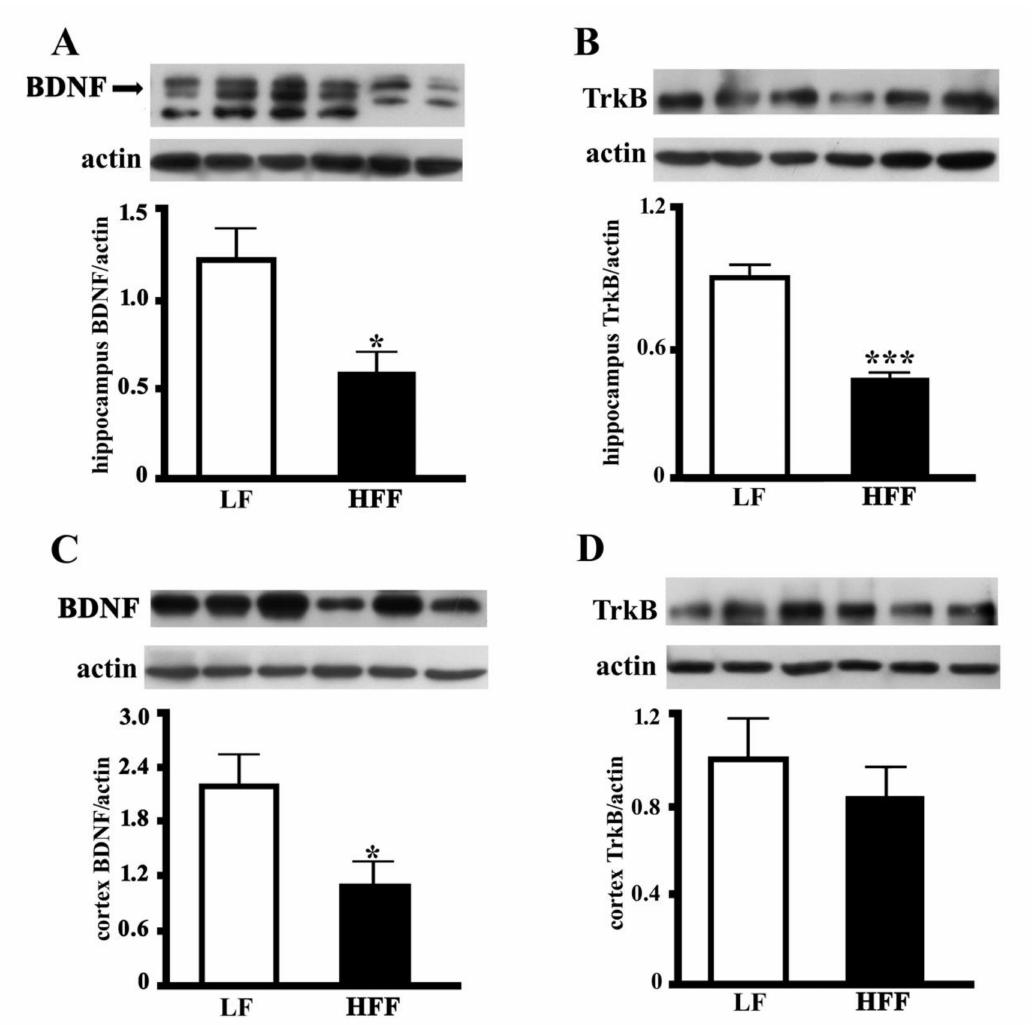
Figure 9. Protein content (with representative western blot) of brain derived neurotrophic factor (BDNF) and tropomyosin receptor kinase b (TrkB) levels in hippocampus ( A , B ), and frontal cortex ( C , D ) from middle-aged rats fed low fat (LF) or high fat-high fructose (HFF) diets for four weeks. Values are the means ± SEM of eight rats. * p < 0.05 compared to low-fat diet (two-tailed Student’s